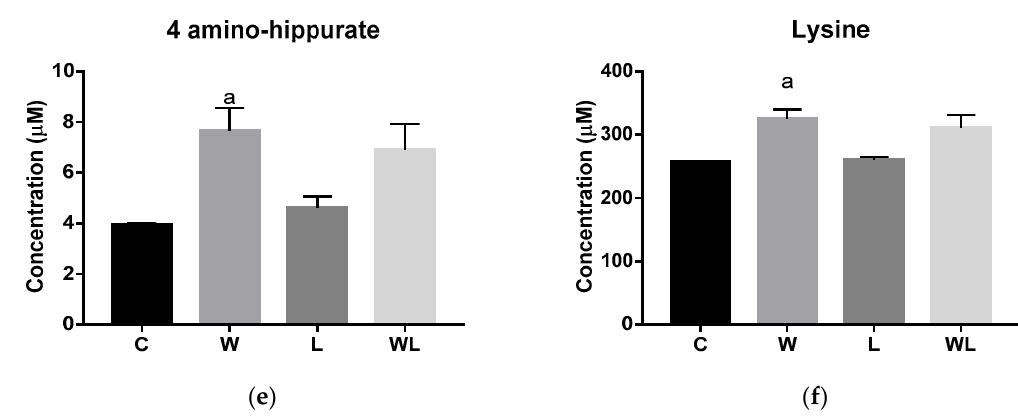
Figure 1. Results obtained from serum samples: ( a ) serum PLS-DA plot score; serum quantified metabolites, as normalized concentrations (µM); ( b ) cytidine; ( c ) uracil; ( d ) glutamine; ( e ) 4-aminohippurate, and ( f ) lysine. Legend: C, Control group ( n = 5); W, Tumor-bearing group ( n = 5); L, Group without tumors and with a maternal leucine-rich diet ( n = 6); WL, Tumor-bearing group with a maternal leucine-rich diet ( n = 6). For more details, see Material and Method section. a , p < 0.05 for statistical difference compared to C group; b , p < 0.05 for statistical difference compared to L group. Table 1. Serum and muscle metabolites obtained from VIP (variable importance in the projection) score analysis of all different experimental groups with or without tumor implant, subjected or not to a maternal nutritional supplementation. VIP Score